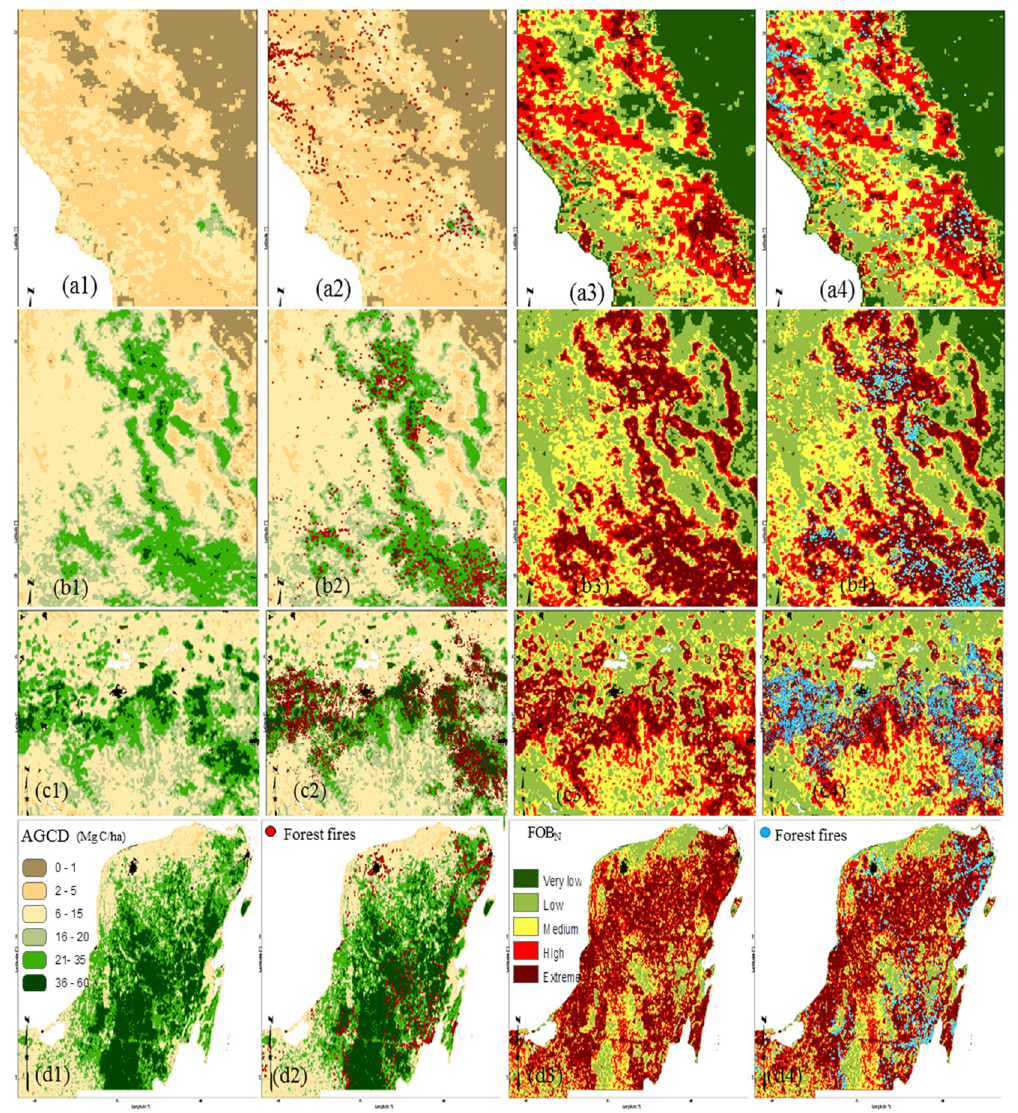
Figure 5. Detailed examples of aboveground carbon density (AGCD, Mg C ha −1 ) and normalized fire occurrence by biomass level (FOB N ) for regions: CHAP and N ( a ); NW and NE ( b ); C ( c ) and SC and SE ( d ). Left panels ( 1 ) show observed AGCD (Mg C ha −1 ), together with observed forest fire suppression records in red ( 2 ). Right panels show predicted FOB N ( 3 ) together with observed forest fire suppression records in blue ( 4 ).